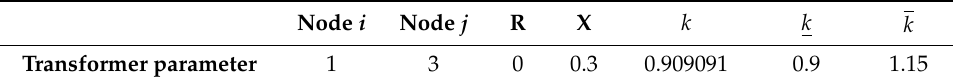
Table 4. Transformer parameters.